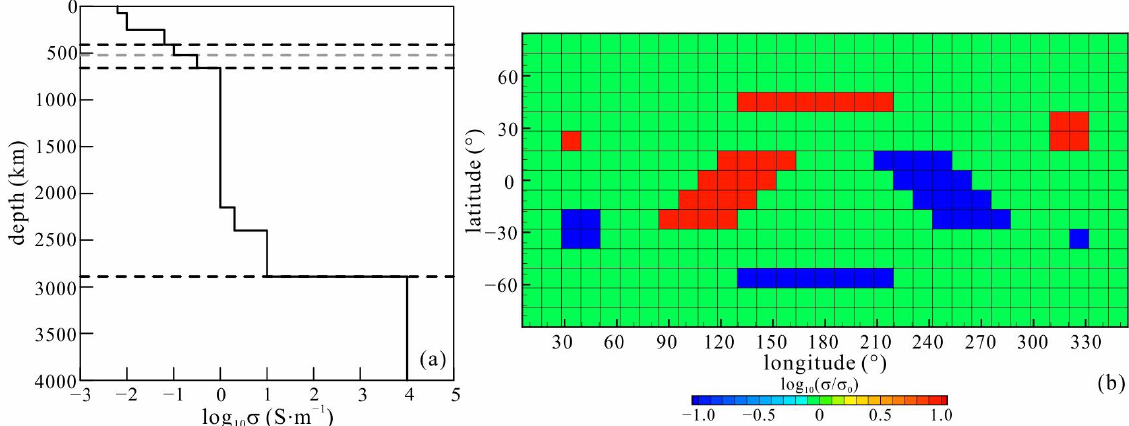
Figure 2. Global average one-dimensional (1D) conductivity model ( a ) and the model with multiscale anomalies at depths of 670–900 km ( b ).